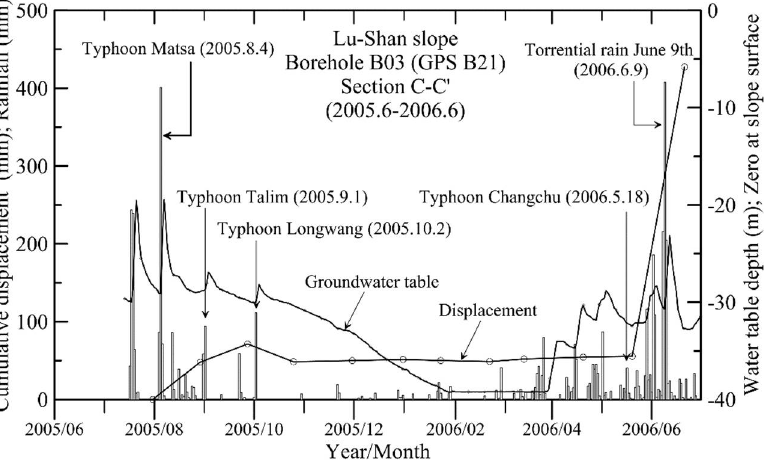
Figure 14. Records of daily rainfall, groundwater levels, and cumulative slope